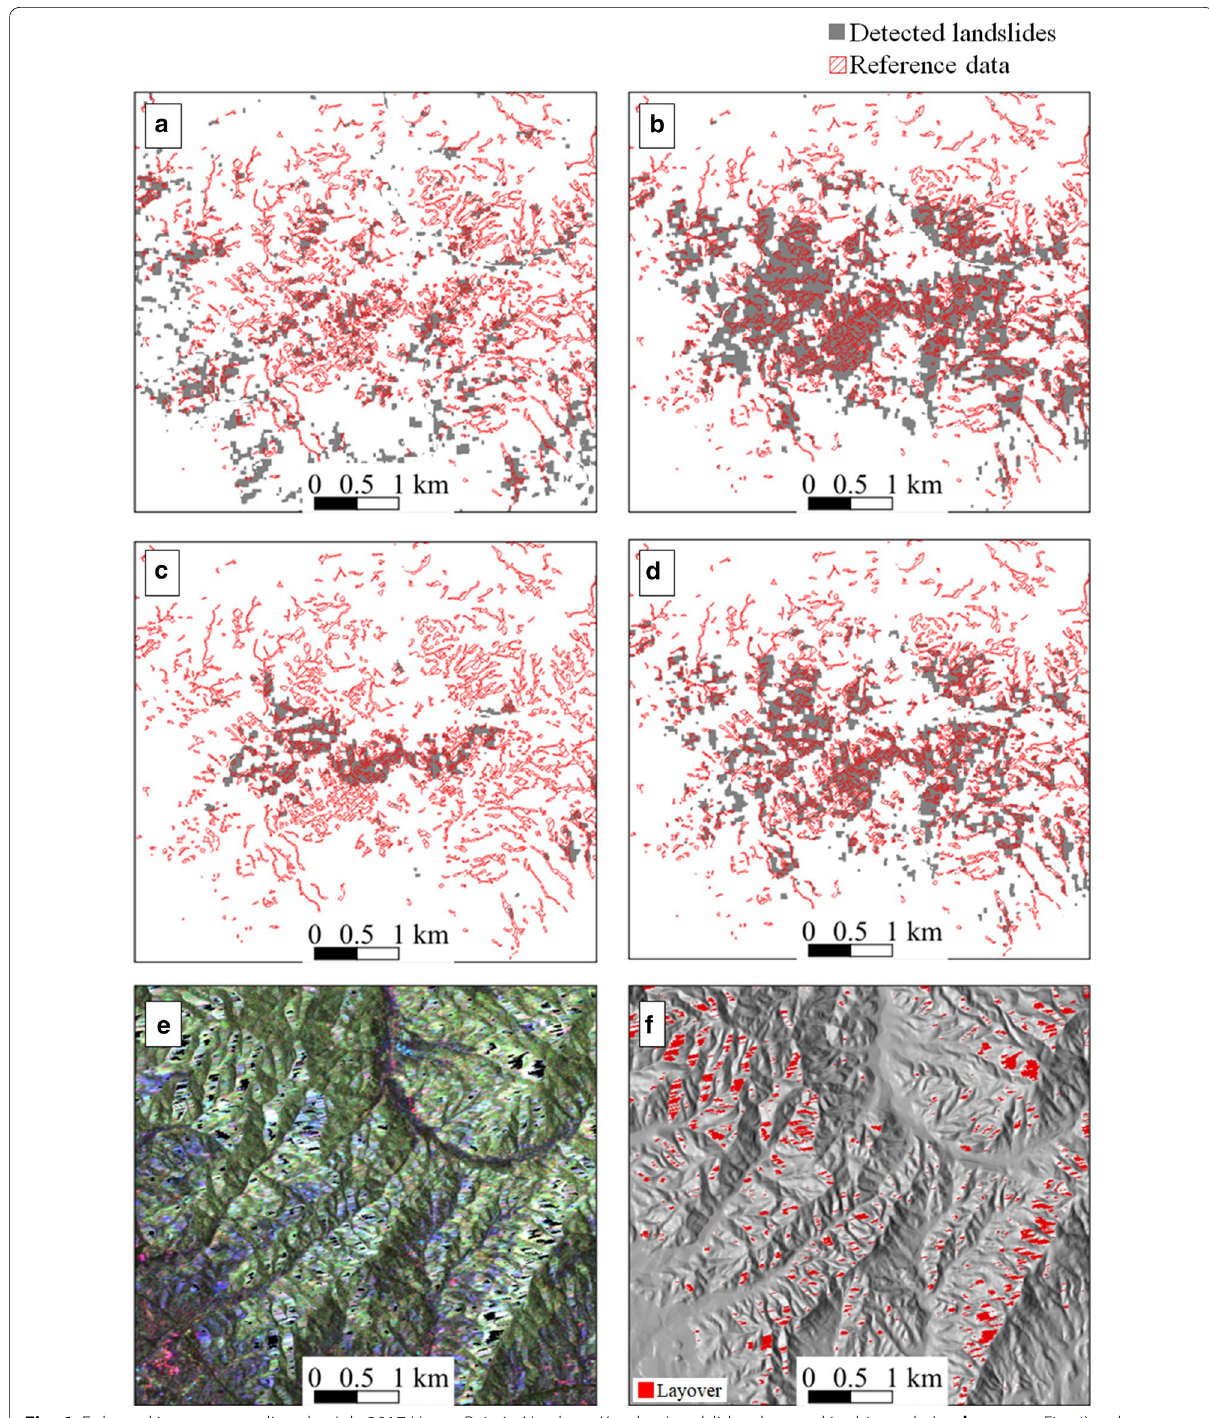
Fig. 6 Enlarged images regarding the July 2017 Heavy Rain in Northern Kyushu. Landslides detected in this study ( a–d , same as Fig. 4), color composite of Pauli components ( e ), and local incidence angle overlaid with the layover areas ( f